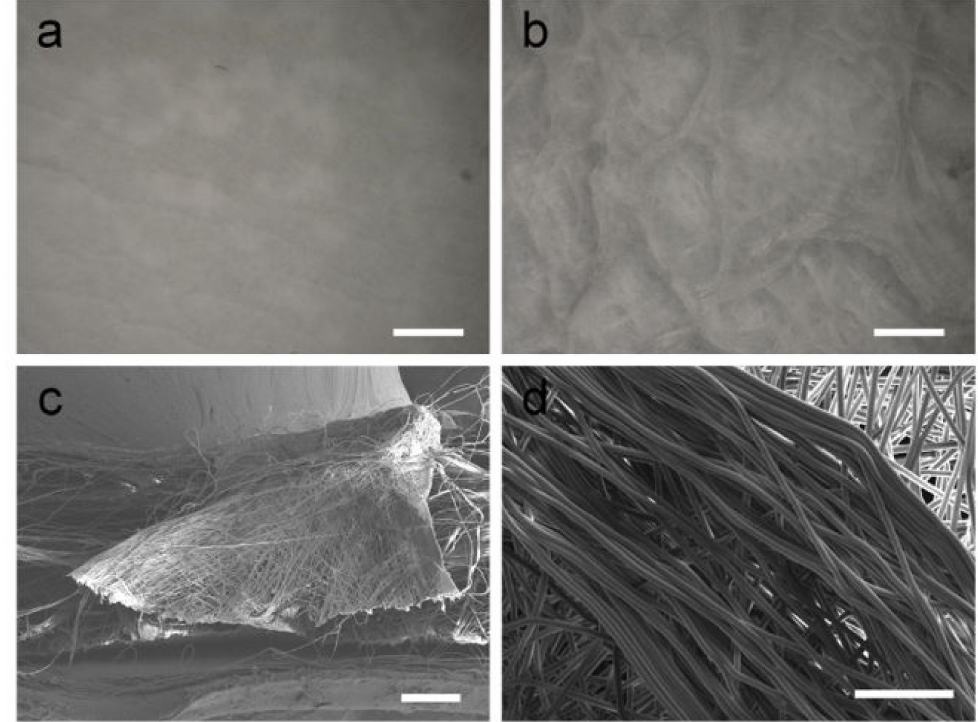
Figure 1. Surface macrostructure of electrospun films when the receiving temperature is ( a ) 23 ◦ C and ( b ) − 10 ◦ C (the humidity is 50%, and the collecting distance between the needle and collector is 15 cm); ( c ) section image of wall-like structures; ( d ) top view of wall-like structures. Scale bars are